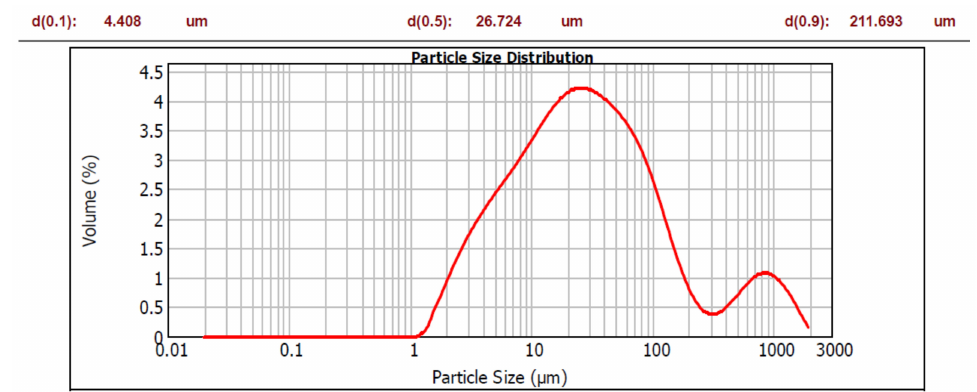
Figure 3. Particle size distribution of concrete.